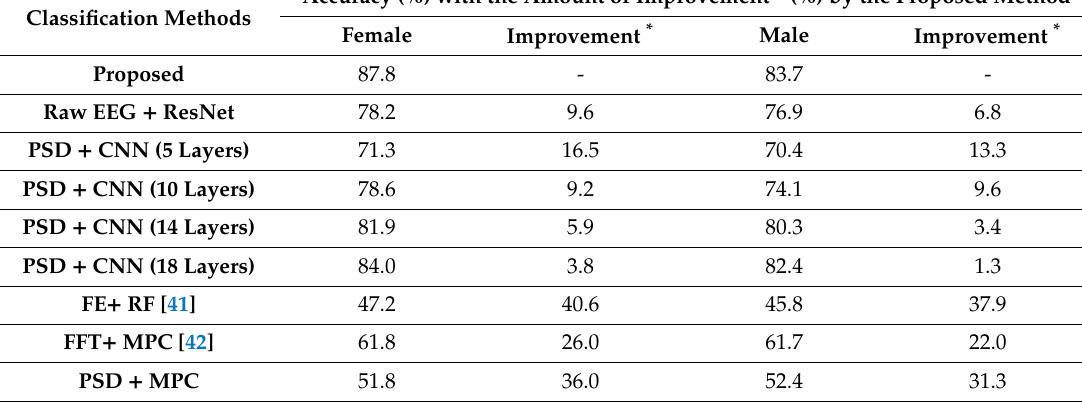
Table 4. Accuracy comparison of di ff erent